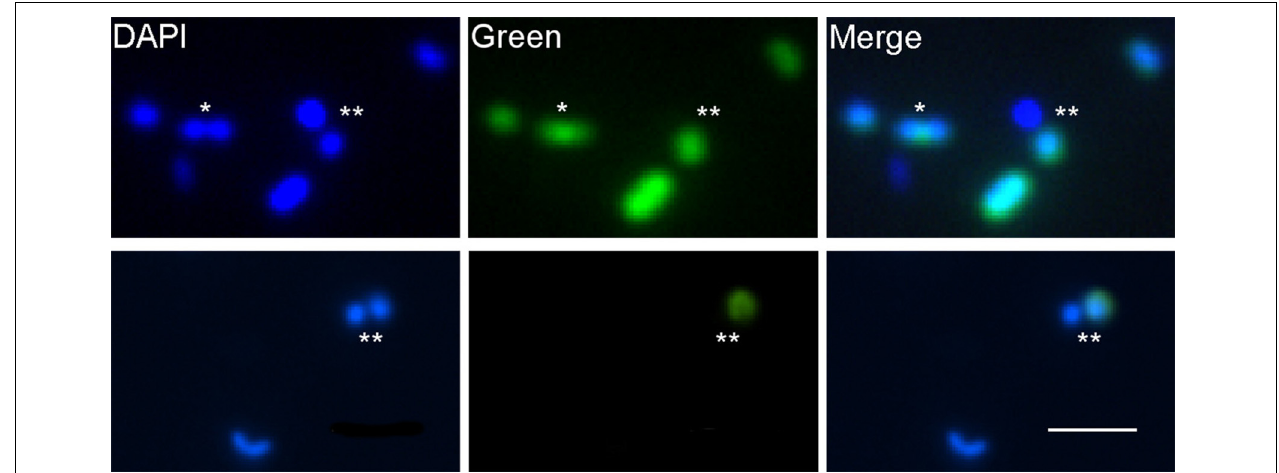
FIGURE 7 | HPG labeling patterns of putatively dividing cells. Each row shows a separate field of view. In most cases, both mother and daughter cells were labeled ( ∗ ). Occasionally, one cell (either mother or daughter) was labeled and the other was not ( ∗∗ ). Scale bar for all images = 2 μ m.